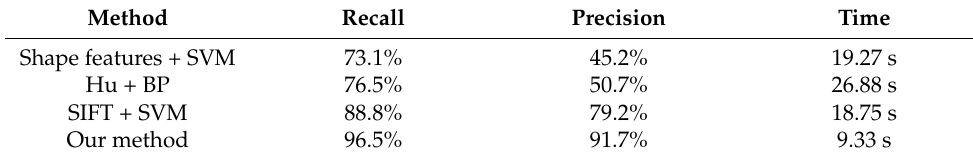
Table 4. Performance of the proposed method and other traditional detection methods.